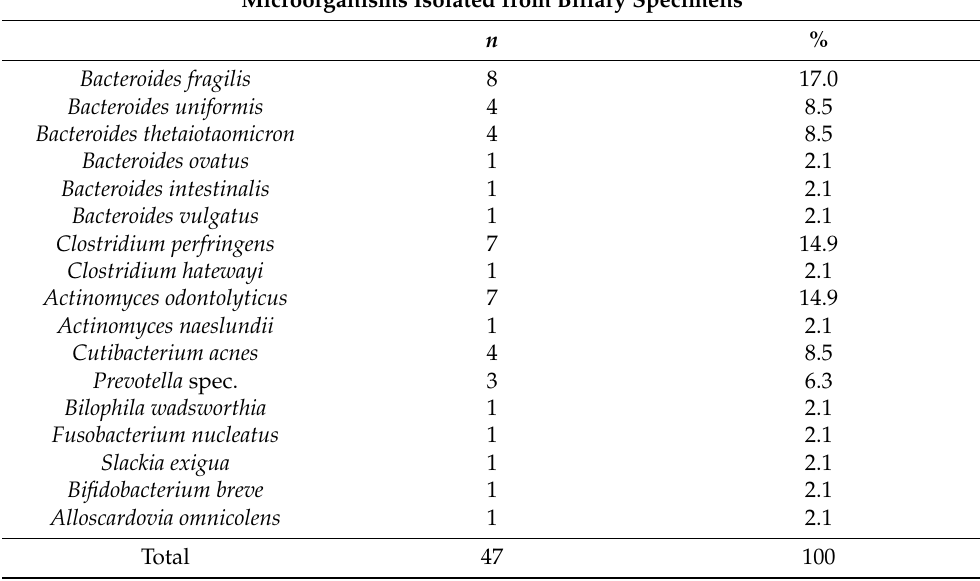
Table 3. The isolated anaerobic strains. The bacteria are sorted within their species from the most frequent to the least.